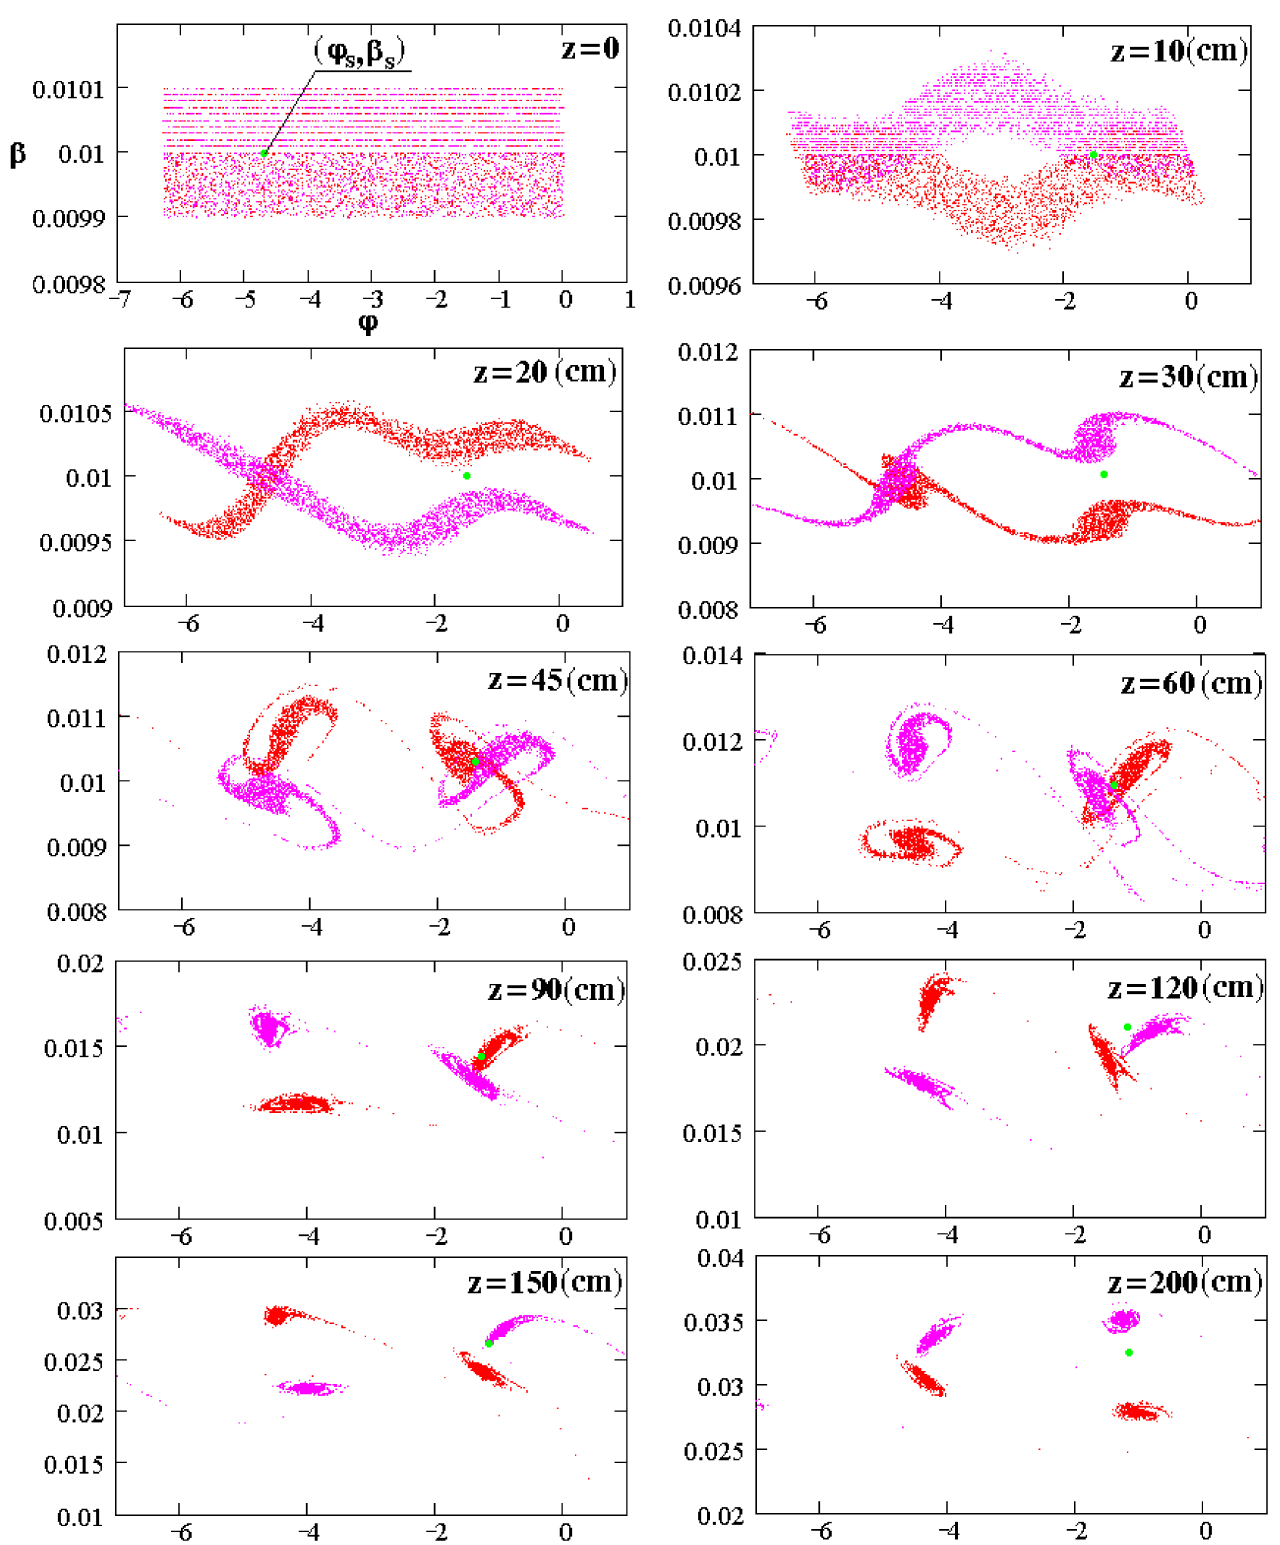
FIG. 8. (Color) The bunching process of the dual beam in the longitudinal phase spaces for different z